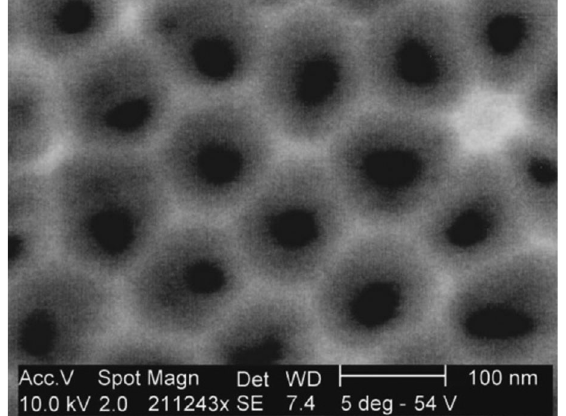
FIG. 1. SEM image of the top surface of a porous alumina sample